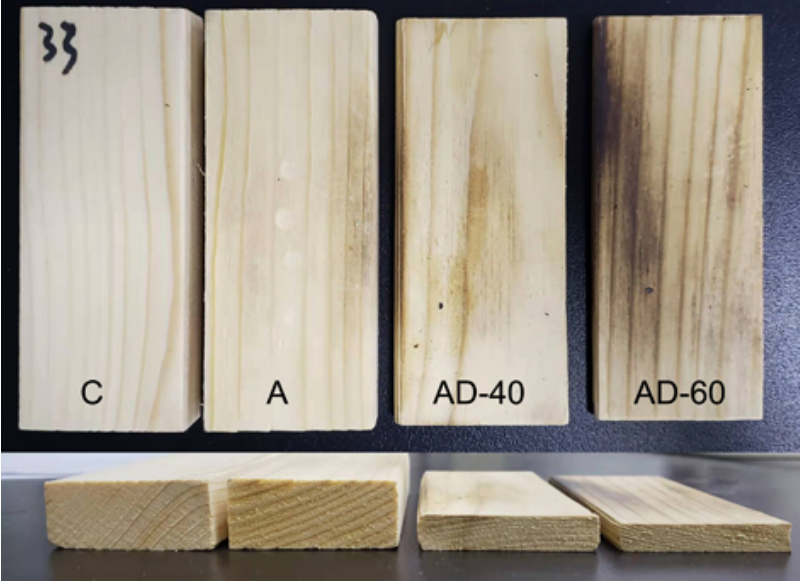
Figure 1. Photo images of the control (C), acetylated (A), 40% compressed (AD-40), and 60% com- pressed (AD-60) spruce samples.